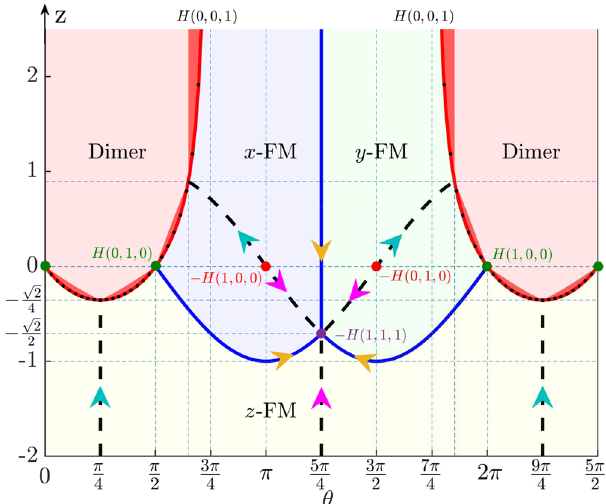
cos (θ) and = z c z ex ( z ex is the exact | − |